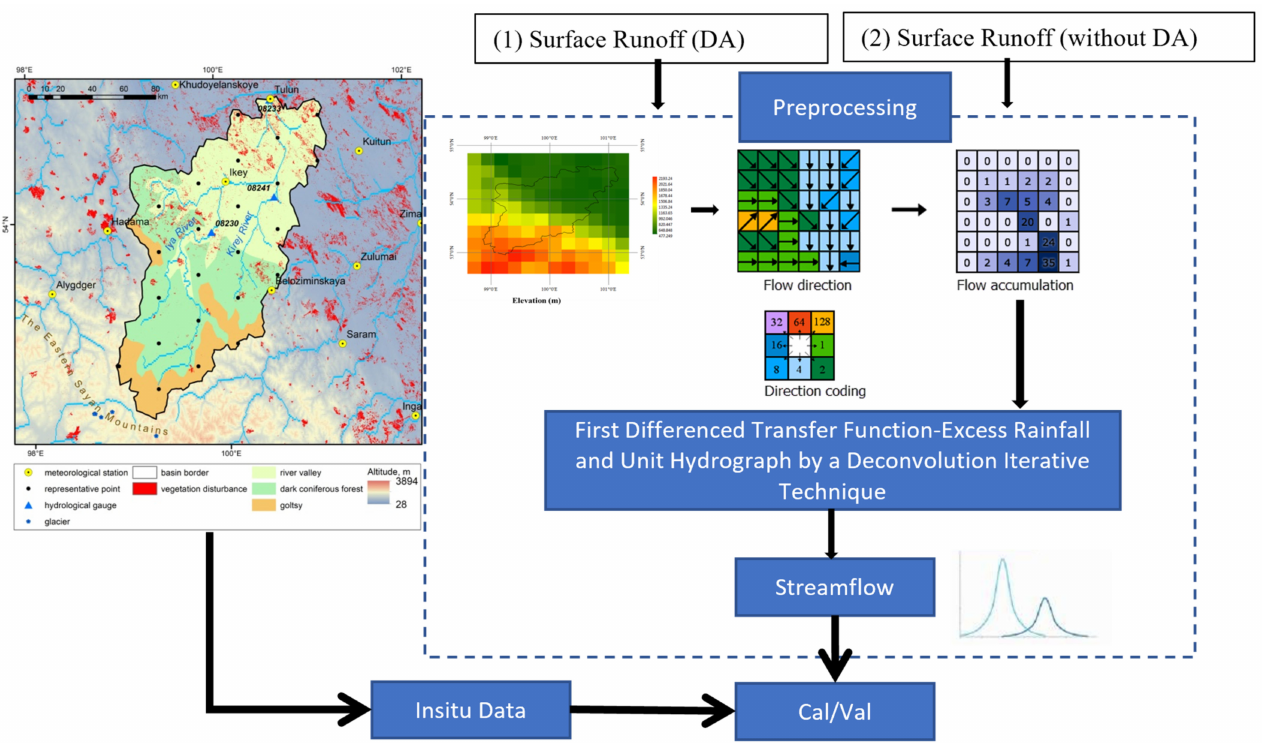
Figure 4. Routing Methodology Flowchart. The grid cells from the LSM simulation are routed to the outlet point of the catchment to estimate the total river discharge at stations having in situ observations. The accumulated flow generates a hydrograph, which is validated with field in situ